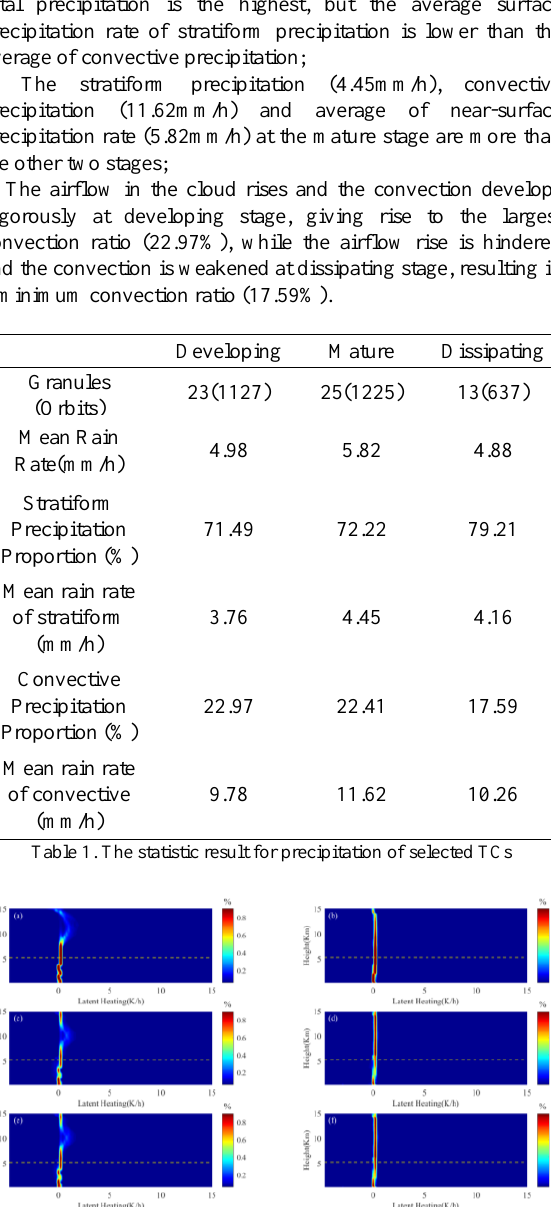
Figure 4. The Contoured frequency by altitude diagrams for latent heating average of stratiform and convective precipitation at each stage. The left (right) column represents the latent heating average profiles of